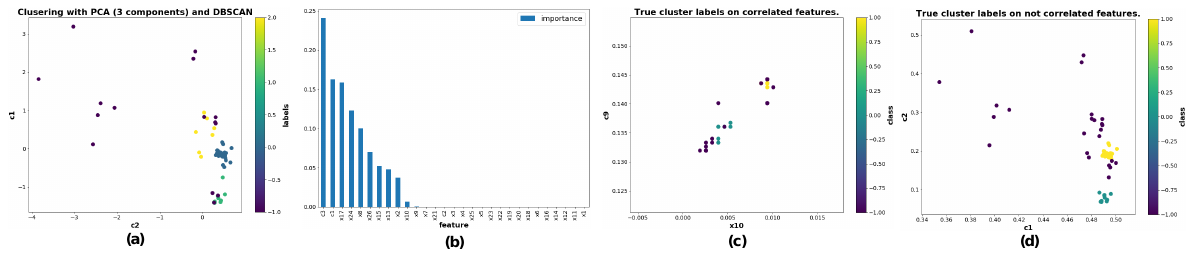
Figure 3. ( a ) DBSCAN clustering after dimensionality reduction with PCA to 3 components.; ( b ) feature importances obtained with random forest classifier. Difficulties in proper cluster identifi- cation on the correlated axis are shown in ( c ). Choosing the set of the uncorrelated axis ( d ) allows for a better overview of data. The presented clustering was done over the DS1